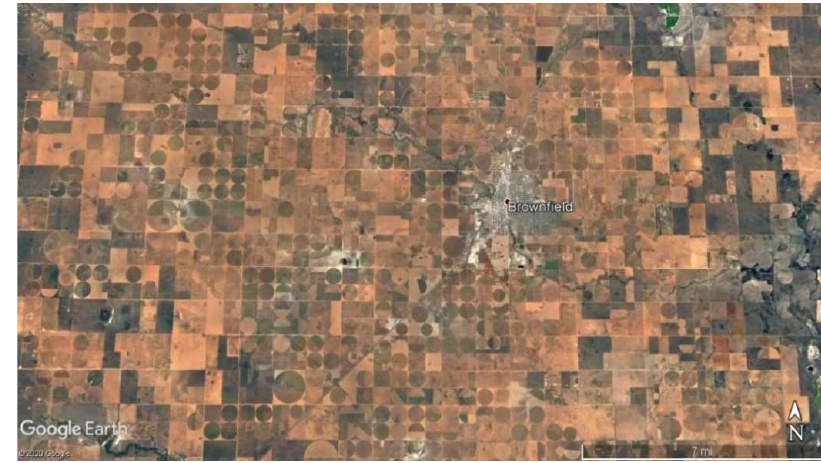
Figure 3. Crop circles in Terry County, Texas (image from Google Earth).